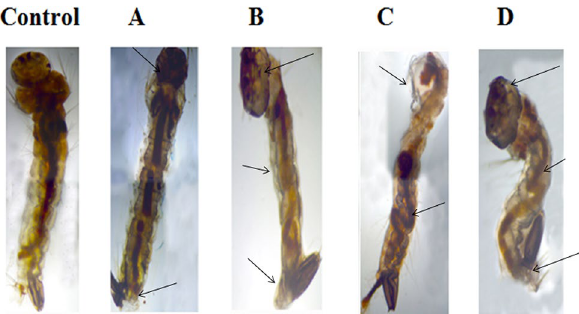
Figure 3. Stereo microscopic image of third instar larvae of An. Stephensi treated with; ( A ) LC50 of L. siceraria aqueous peel extract (261.67 ppm); ( B ) LC90 of L. siceraria aqueous peel extract (606.49 ppm); ( C ) LC50 of L.